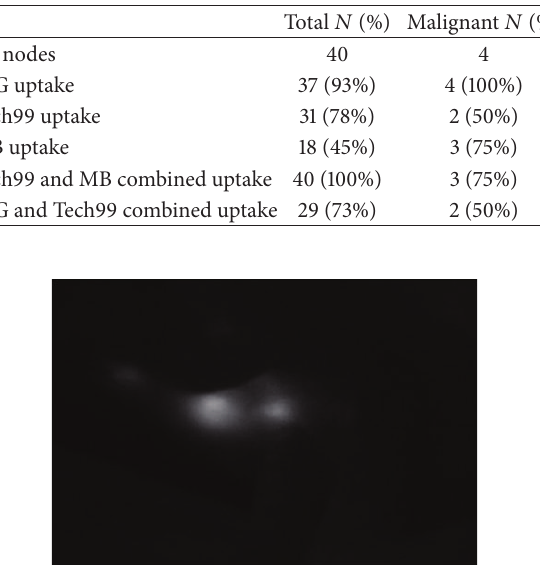
Figure 1: Sentinel nodes imaged with the SPY machine through the skin, prior to incision.